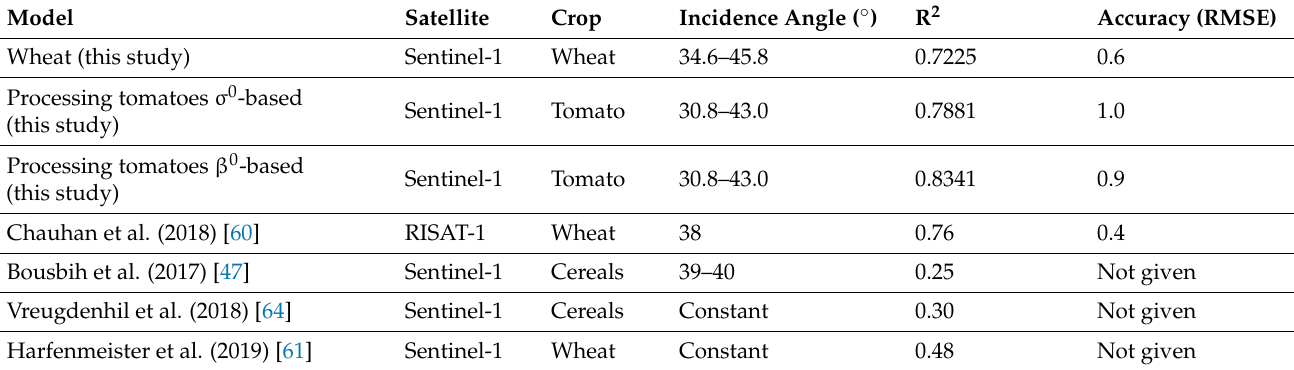
Table 6. Comparison of vegetation LAI estimation models based on Sentinel-1 and RISAT-1 C-band SAR.